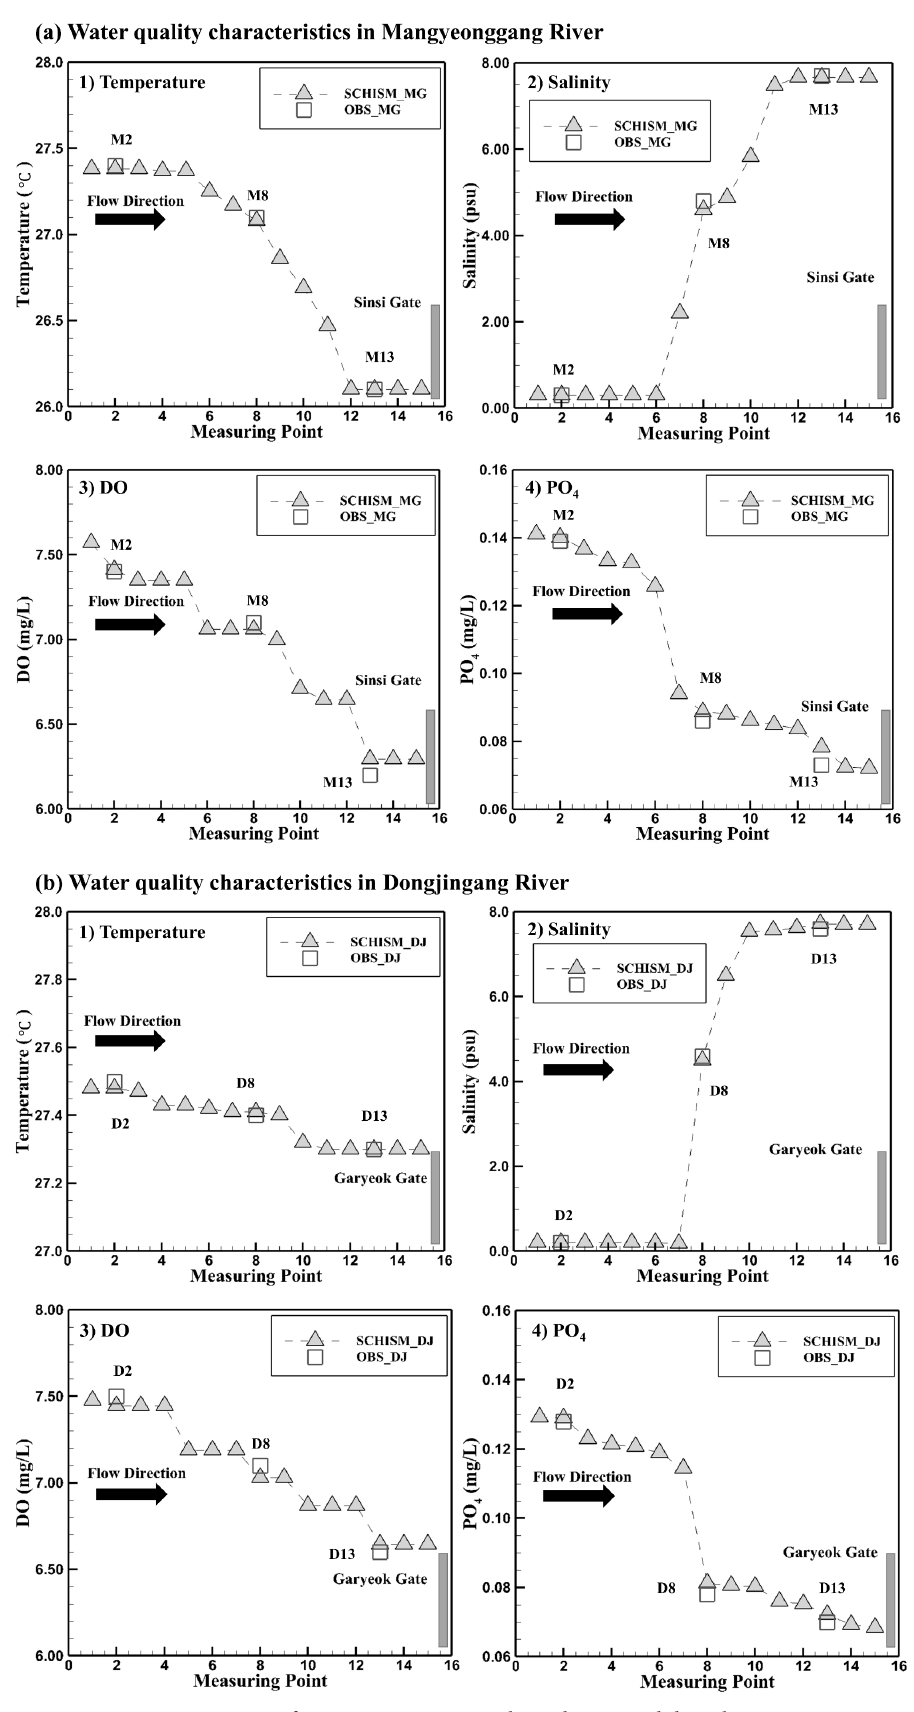
Figure 6. Comparison of SCHISM-CoSiNE results and measured data about 1) temperature, 2) salinity, 3) concentration of dissolved oxygen, 4) concentration of